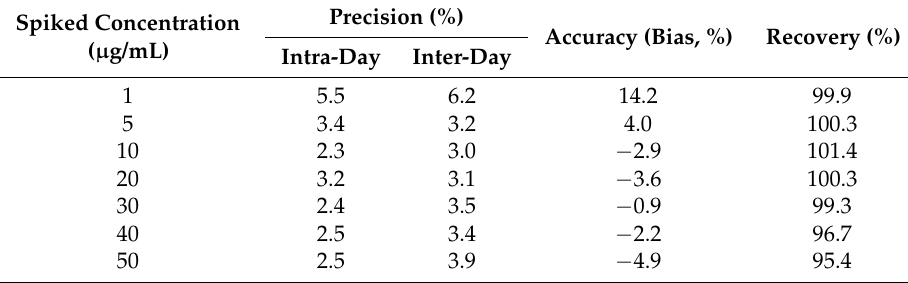
Table 1. Intra- and inter-day precision, accuracy, and